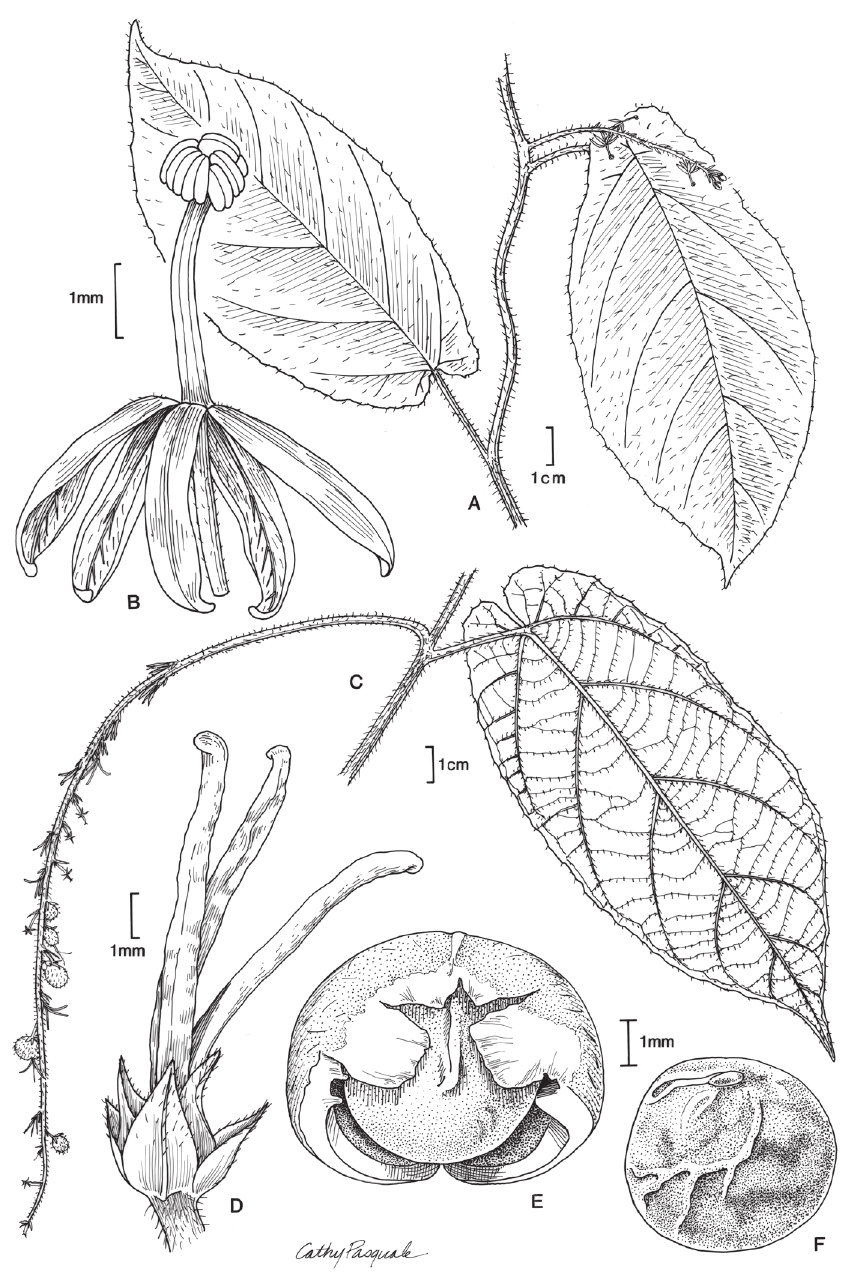
Figure 1. Illustration of Monadelpha guayanensis . A habit showing staminate inflorescence B staminate flower C habit showing infructescence D pistillate flower E mericarp of dehisced capsule with enclosed seed F seed, lateral view with hilum at top. Sources: A, B based on Stergios & Aymard 9182 (MO) C–F based on Stergios & Aymard 9182 (NY). Illustration by Cathy Pasquale reproduced from Gillespie (1994b) with permission from the Missouri Botanical Garden